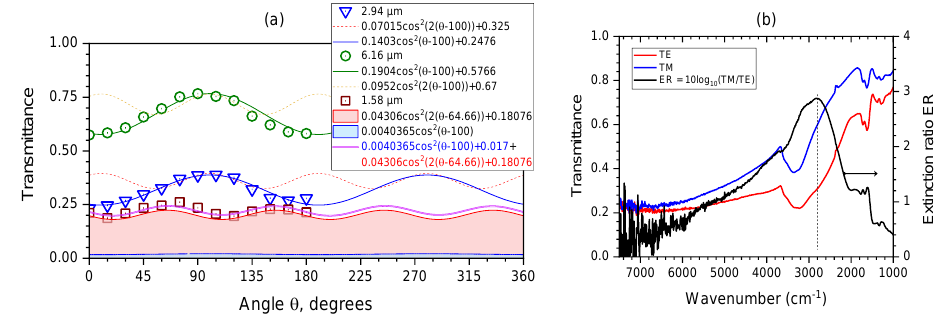
Figure 7. ( a ) IR transmittance spectra of the fabricated GO polariser measured by the microscope FTIR spectrometer with a parallel polariser and analyser. Transmittance was fitted considering contributions from absorbance and retardance at the 1.58, 2.94, and 6.16 µ m bands as marked in the transmittance spectra (Figure 6b). The best fit formulae are shown as retrieved from the MATLAB best fit routine without rounding. See text for details. ( b ) The experimentally determined spectrum of the extinction ratio ER of the GO polariser with period P = 4 µ m, thickness d = 1 µ m and ribbon width w = 2 µ m (see Figure 8 for a family of the parameter